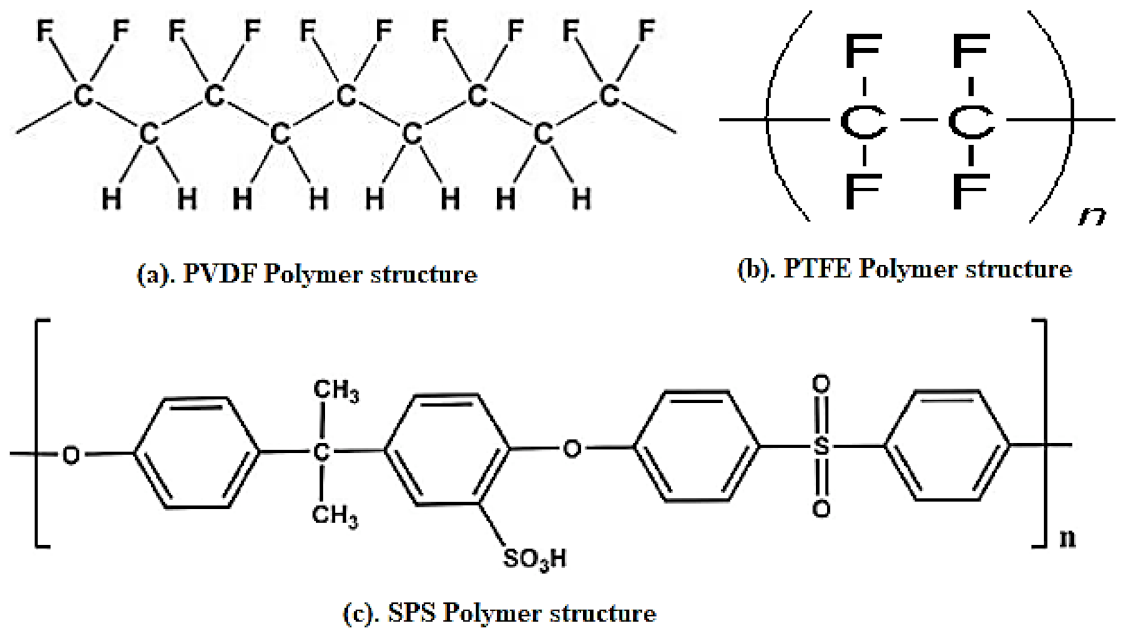
Figure 6. Binders, ( a ). PVDF-polymeric structure; ( b ). PTFE-polymeric structure; and ( c ). SPS-polymeric structures, used for electrode fabrication. Reproduced with permission from